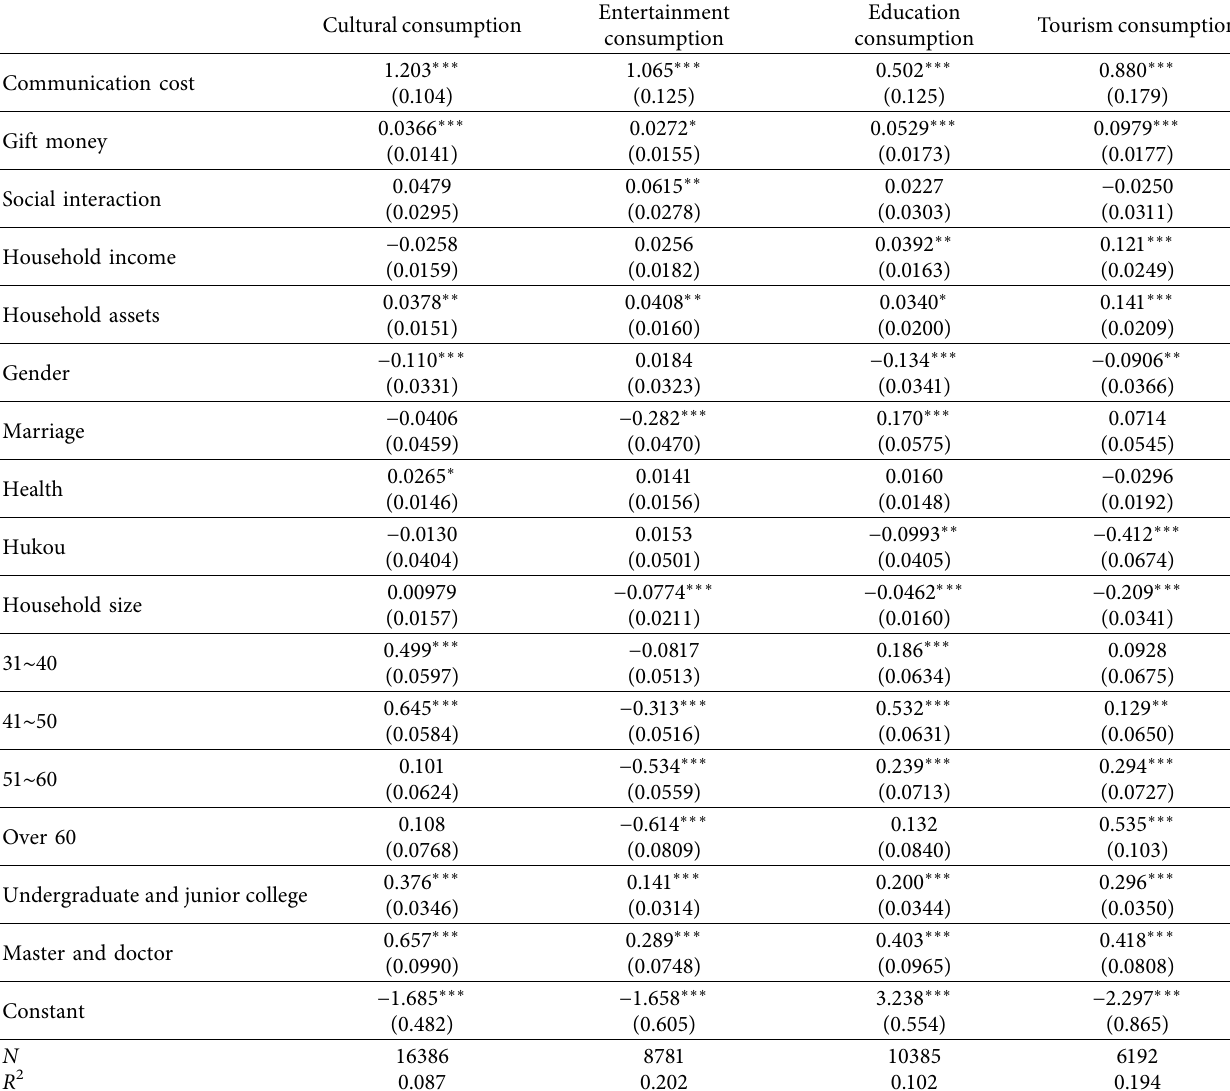
Table 7: Second-stage regression of instrumental